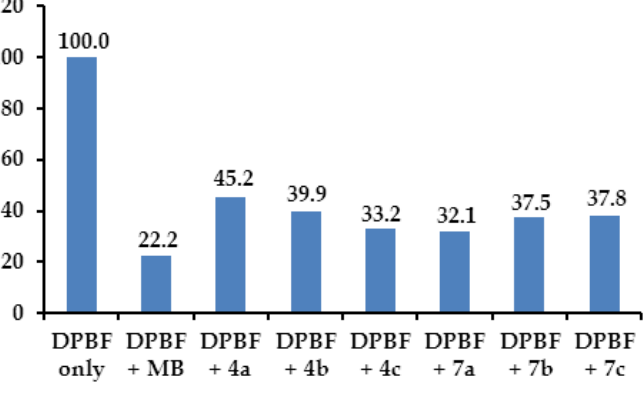
Figure 5. Comparative absorbance decay (%) of 1,3-diphenylisobenzofuran (DPBF) (50 μ M in DMSO) at 418 nm after photoirradiation (total light dose 2 J/cm 2 , irradiation time 15 min) in the absence (control) and presence of 1 μ M of MB (methylene blue), 4a – 4c and 7a – 7c . The data are expressed as mean of three experiments.